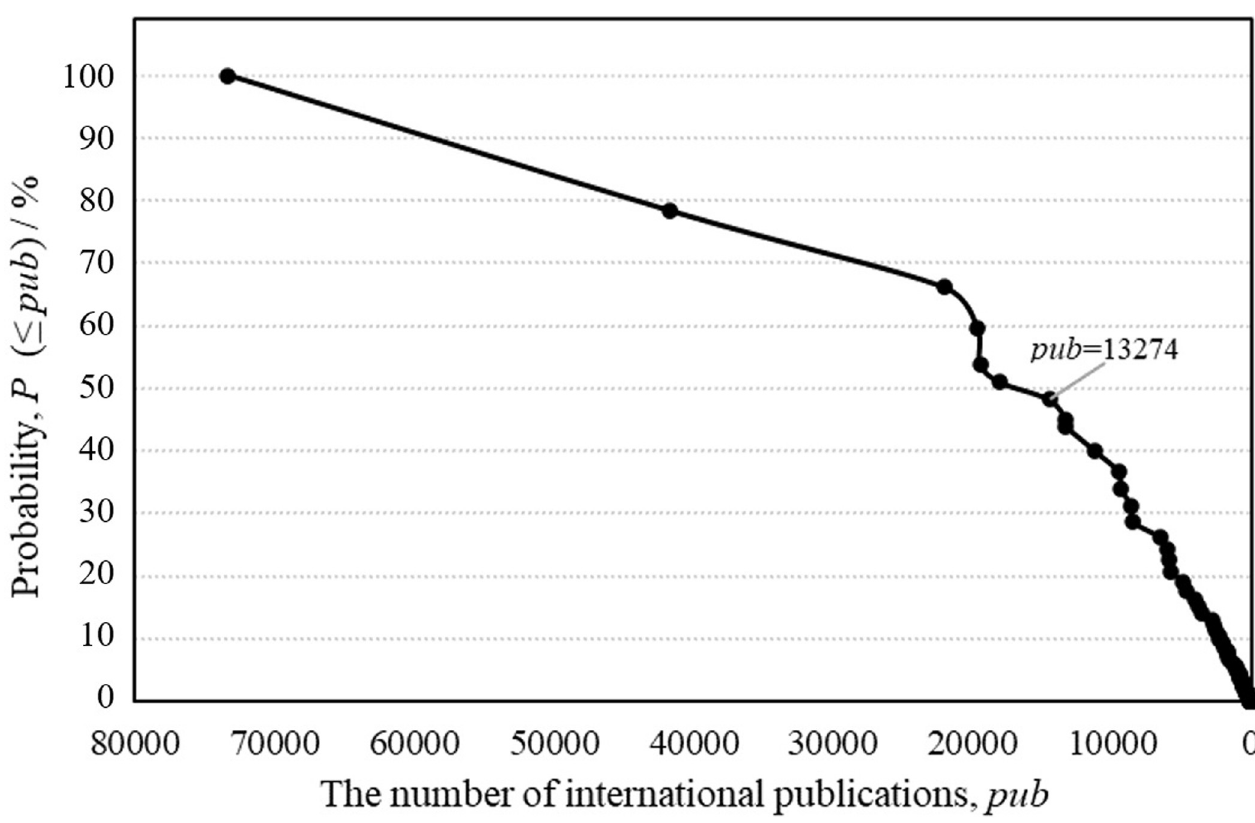
Fig 1. The cumulative distribution of the number of international